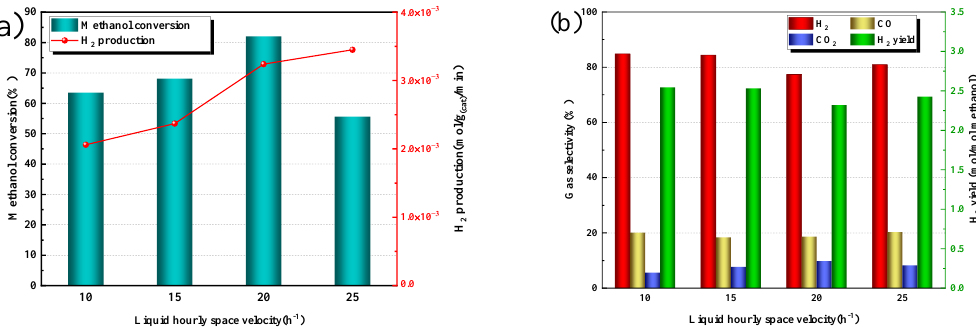
Figure 7. The MSR performance of the La 0.6 Sr 0.4 CeO 3- δ at different LHSV: ( a ) methanol conversion (left Y) and hydrogen production of 1 g catalyst (right Y); ( b ) gas selectivity (left Y) and hydrogen yield (right Y).